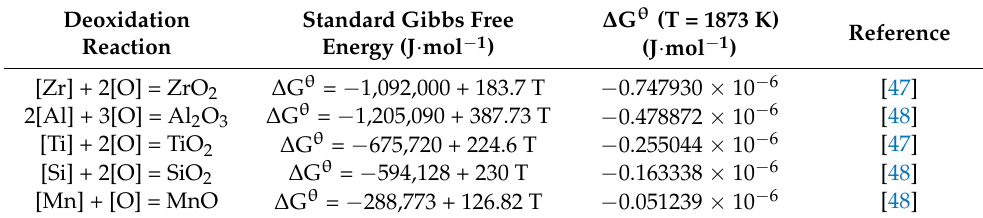
Table 2. The deoxidation reaction and standard Gibbs free